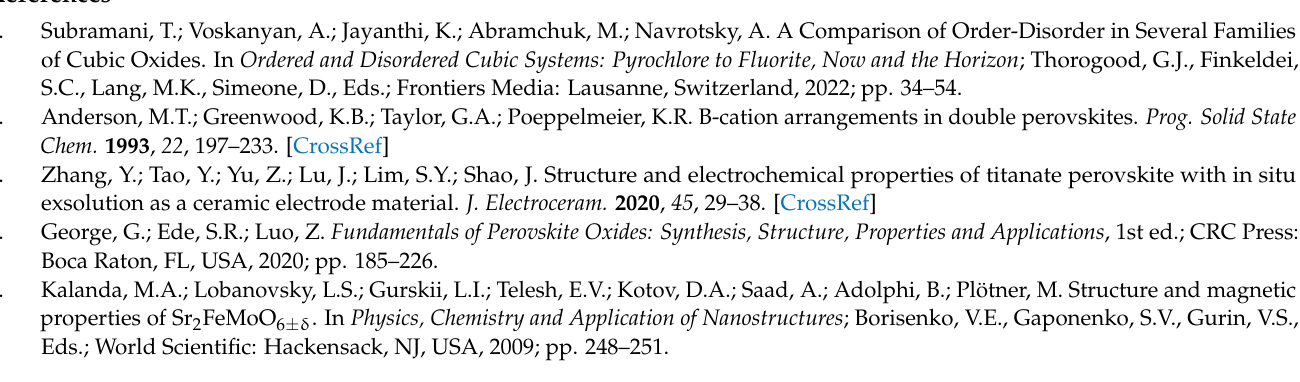
values based on the Rietveld Refinement of XRD data of Sample 1 to perform the indexation of the corresponding XRD pattern, Figure S4: Both unit-cell parameters and corrected observed 2-theta values based on the Rietveld Refinement of XRD data of Sample 2 to perform the indexation of the corresponding XRD pattern, Figure S5: Both unit-cell parameters and corrected observed 2-theta values based on the Rietveld Refinement of XRD data of Sample 3 to perform the indexation of the corresponding XRD pattern, Figure S6: Unit-cell parameters, the corrected observed and calculated peak positions, and the respective difference obtained from the McMaille software for the case of Sample 1, Figure S7: Unit-cell parameters, the corrected observed and calculated peak positions, and the respective difference obtained from the McMaille software for the case of Sample 2, Figure S8: Unit- cell parameters, the corrected observed and calculated peak positions, and the respective difference obtained from the McMaille software for the case of Sample 3, Figure S9: χ m T vs. T curve showing the N é el temperature for Sample 1, Figure S10: Variation of M along with M − 1 vs. temperature for Sample 2 from 2 to 40 K; Table S1: Structural parameters, average crystallite size, together with conventional discrepancy factors from Rietveld refinement of XRD data for Sample 1, Sample 2, and Sample 3 [30], Table S2: Structural parameters, results of phase analysis together with conventional discrepancy factors from Rietveld refinement of XRD pattern for Sample 3, Table S3: Bond distances and bond angles for Sample 1, Sample 2, and Sample 3, Table S4: Structural parameters, average crystallite size, together with conventional discrepancy factors from Rietveld refinement of XRD data for Sample